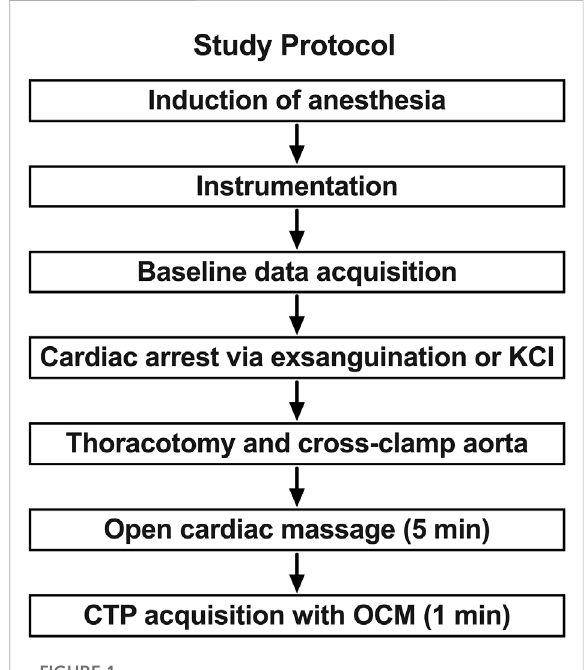
FIGURE 1 Study protocol and sequence. In phase 1 anesthesia is induced and the animal is prepared with catheter introduction and monitoring device placement. In phase 2 the animal is closely monitored, and baseline data is acquired. The animal is then exsanguinated to arrest or administer potassium chloride (KCl) in normovolemic model. This is followed by the placement of an aortic cross clamp in phase 3. Open cardiac massage (OCM) is